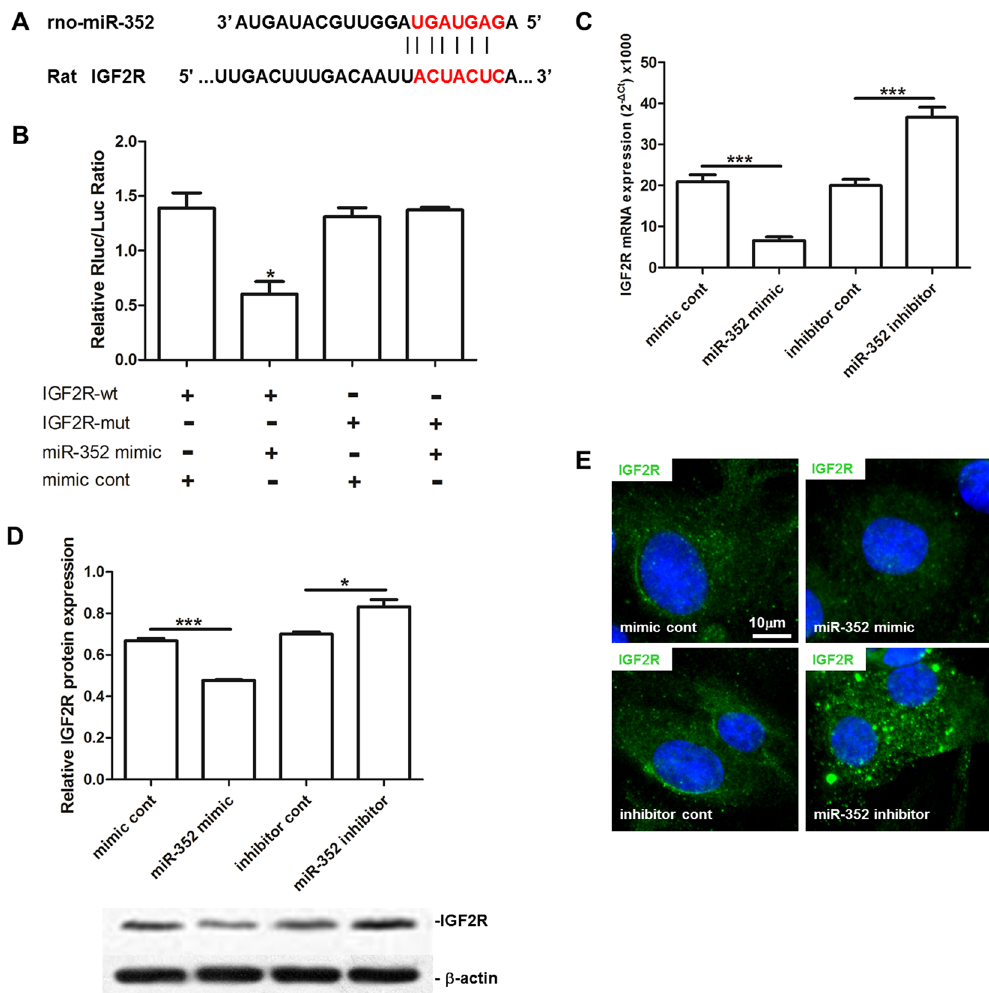
Figure 4. Identification of IGF2R as a target of miR-352 in rat aorta endothelial cells (RAECs). ( A ) Seed sequence of miR-352, and the complementary 3 ′ -UTR sequence of IGF2R. ( B ) Luciferase analysis. Luciferase activity of the IGF2R wt 3 ′ -UTR construct but not the IGF2R mut construct, was decreased in the miR-352- expressing cells ( * P < 0.05, n = 3). ( C – E ) Overexpression or inhibition of miR-352 in RAECs resulted in a decrease or an increase in IGF2R expression on both the mRNA ( C ) and protein ( D , E ) levels as determined by qPCR ( C ), western blot ( D ) and immunofluorescence staining ( E ), respectively. Specific fluorescence in green, and nuclei staining in blue ( *** P < 0.001, * P < 0.05, n =